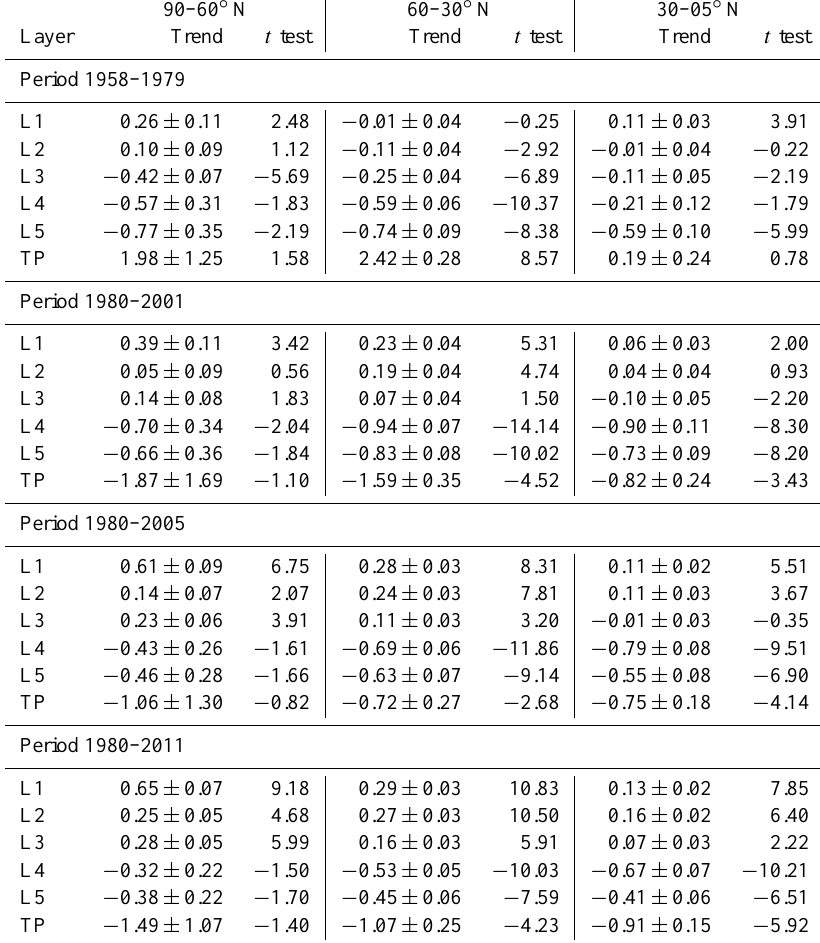
Table 1. Trend calculations in Northern Hemisphere summer (JJA) based on the monthly normalized time series of the layer mean temper- ature ( ◦ Cdecade − 1 ) and tropopause pressure (TP; hPadecade − 1 ) calculated from NCEP reanalysis and filtered from natural variations